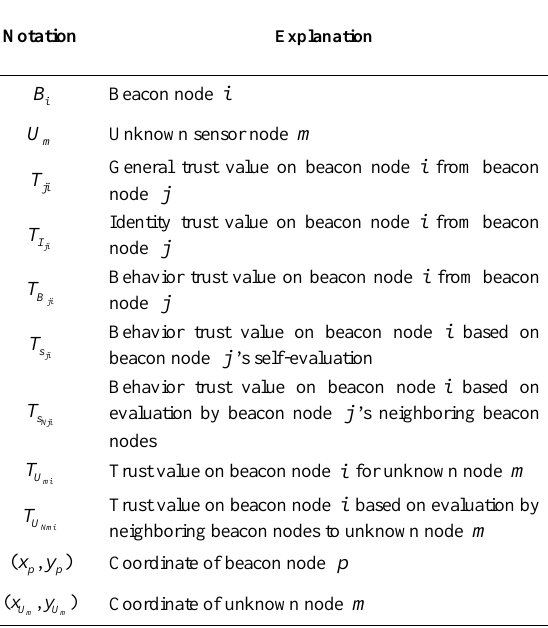
Table 1. List of